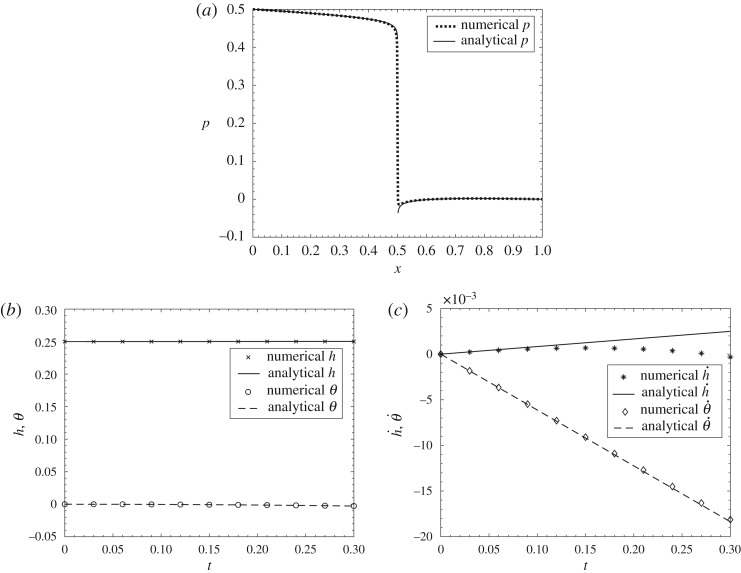
Comparison between small-time analytical solutions and numerical solutions for M^=5, g^=0.04 at early times (a) pressure at time t = 0 + , (b) h and θ against t, (c) h˙ and
θ˙ against t.